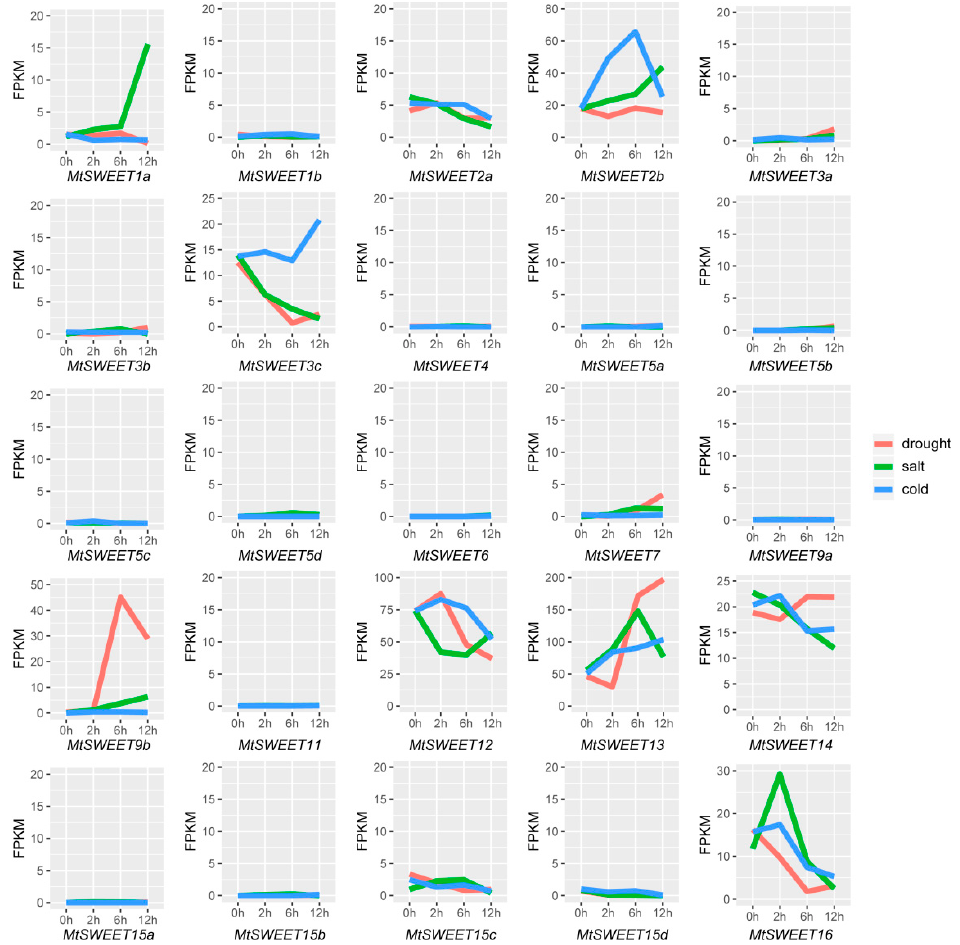
Figure 6. Expression patterns of MtSWEET genes in response to cold, drought, and salt stresses. The expression levels of the MtSWEET genes are shown as the FPKM values based on the RNA-seq data in our previous study [50] .